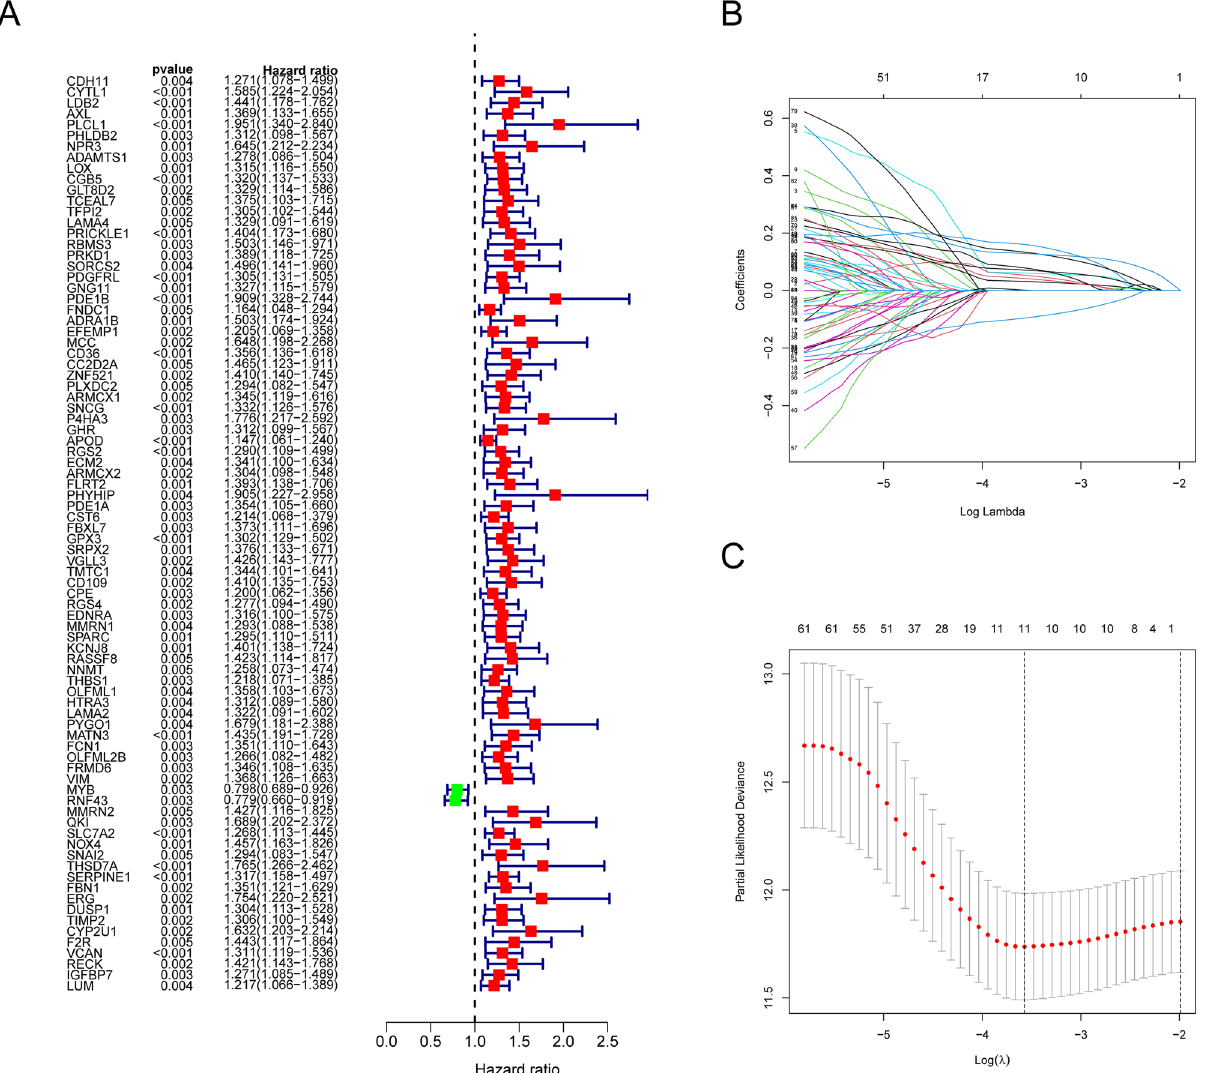
Figure 5. The development of NRGsig in the TCGA-GC cohort. ( A ) The prognostic-related genes determined by univariate Cox-regression analysis. Red represents risk genes; green represents protective genes. ( B ) LASSO regression of prognostic-related genes. ( C ) Cross ‐ validation for tuning the parameter selection.